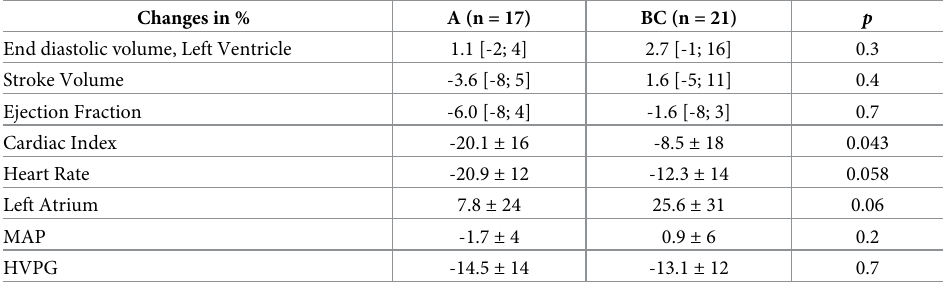
HVPG Data are presented as mean ± SD or medians and interquartile ranges, as appropriate.